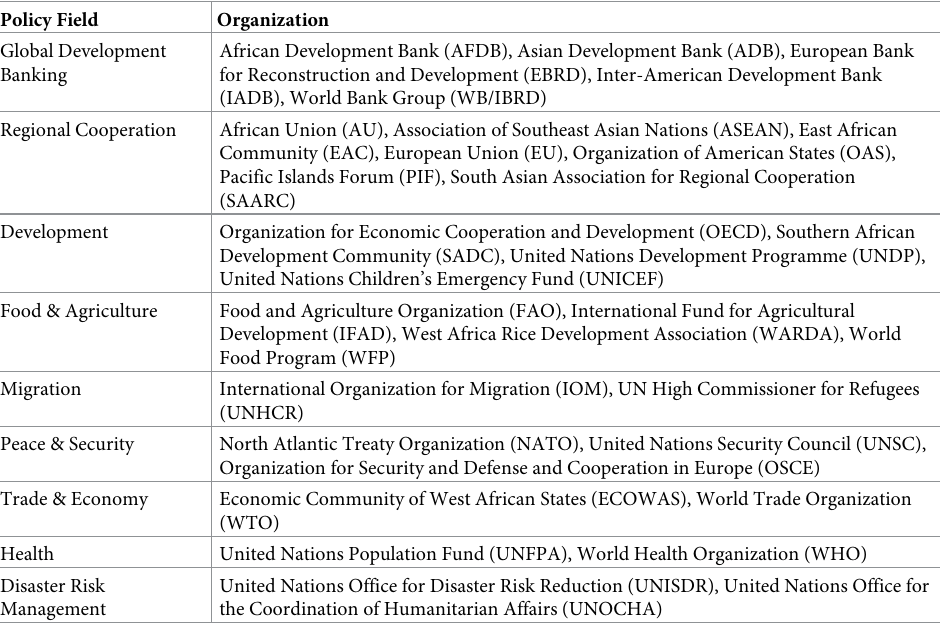
Table 1. Overview of issue areas and IOs included in the